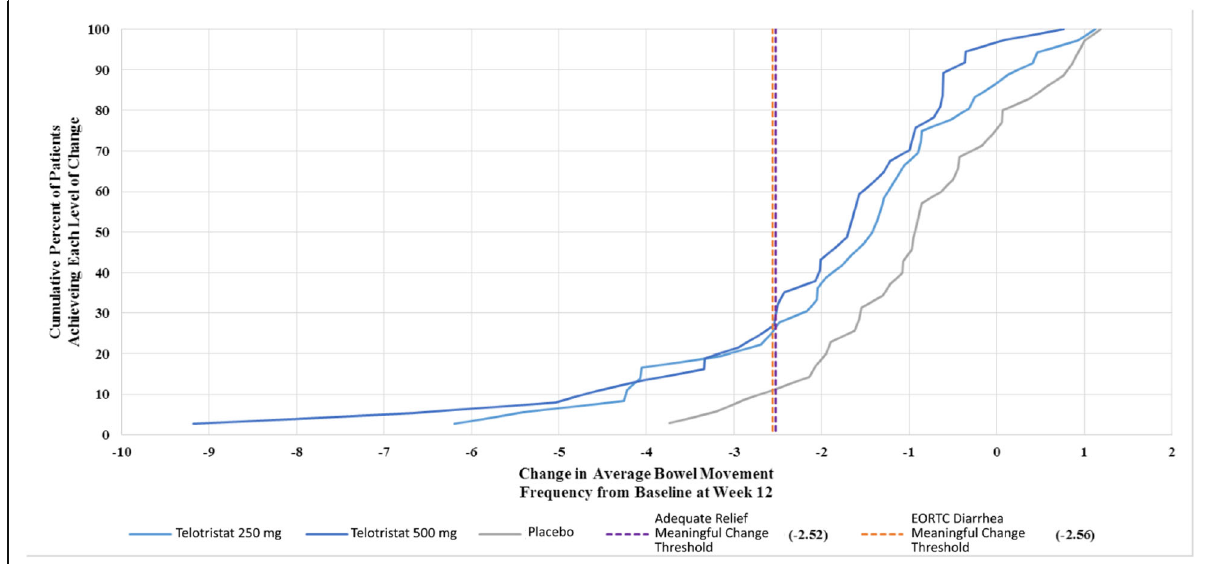
Fig. 4 CDF of Change in Average BM Frequency from Baseline at Week